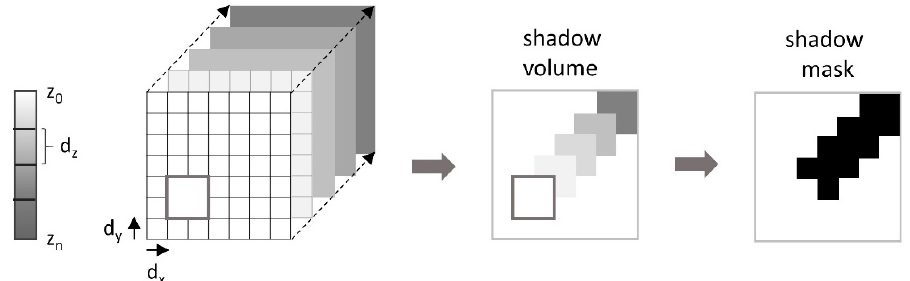
Figure 5. Overview of the DSM model-based shadow detection approach, in this paper referred to as shadow volume approach.